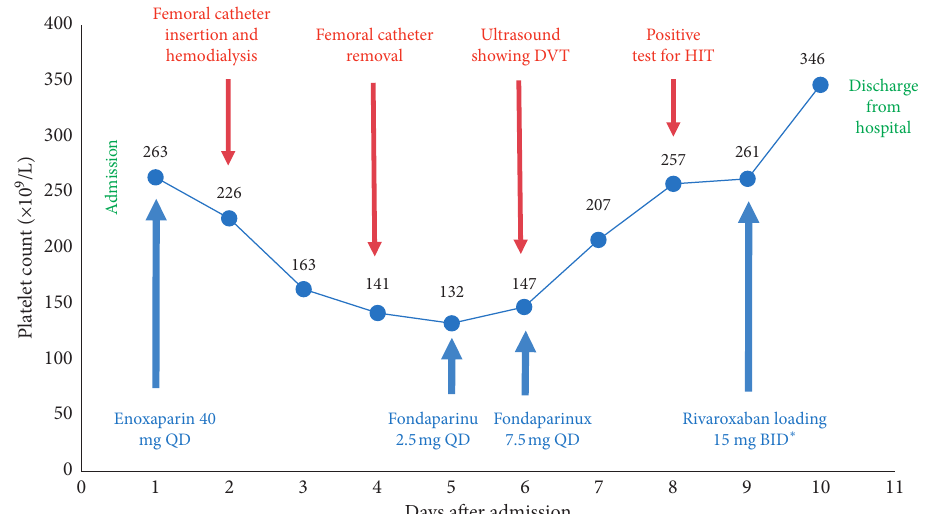
Figure 1: Platelet count charted against time and timeline of clinical events and medications used until day of discharge. QD, once daily; BID, twice per day; DVT, deep venous thrombosis; HIT, heparin-induced thrombocytopenia. ∗ Loading for 21 days and then 20mg QD to complete a total of three